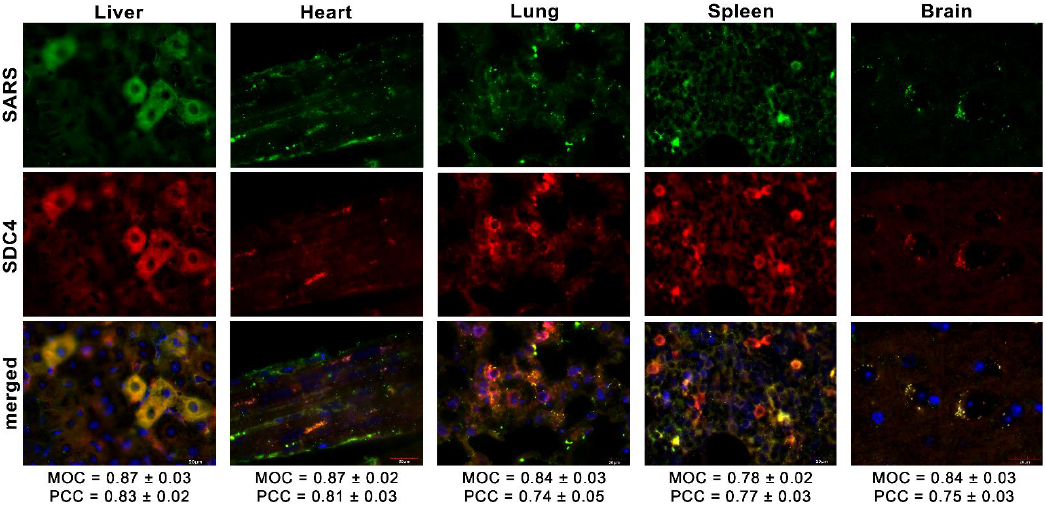
Figure 8. Colocalization of SDC4 with SARS-CoV-2 in various organs of the mice. Liver, heart, lung, spleen, and brain samples of mice receiving i.v. administration of inactivated SARS-CoV-2. Tissue SDC4 is detected with an APC-labeled SDC4 antibody, while SARS-CoV-2 with an AF 488-labeled spike antibody. Scale bar = 20 μm. MOC ± SEM and PCC ± SEM for the overlap and colocalization of SARS-CoV-2 with SDC4 were calculated by analyzing 18 images from 3 samples of each animal.